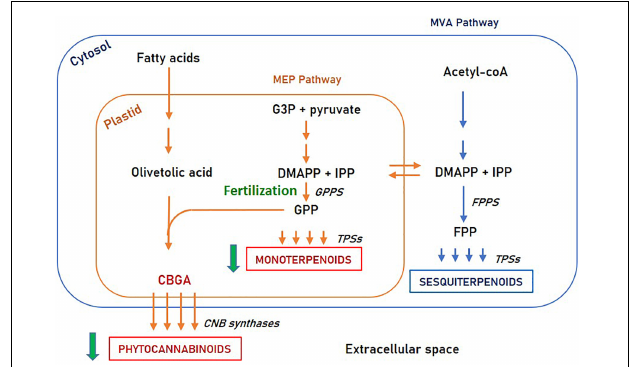
FIGURE 7 | Phytocannabinoids and terpenoids biosynthesis pathways. Fertilization affects the MEP pathway in an enzymatic step upstream to GPP synthase. MEP, Methylerythritol phosphate; MVA, Mevalonate; G3P, Glyceraldehyde 3-phosphate; DMAPP, Dimethylallyl diphosphate; IPP, Isopentenyl diphosphate; GPP, Geranyl diphosphate; FPP, Farnesyl diphosphate; GPPs, GPP synthase; FPPS, FPP synthase; TPSs, Terpene